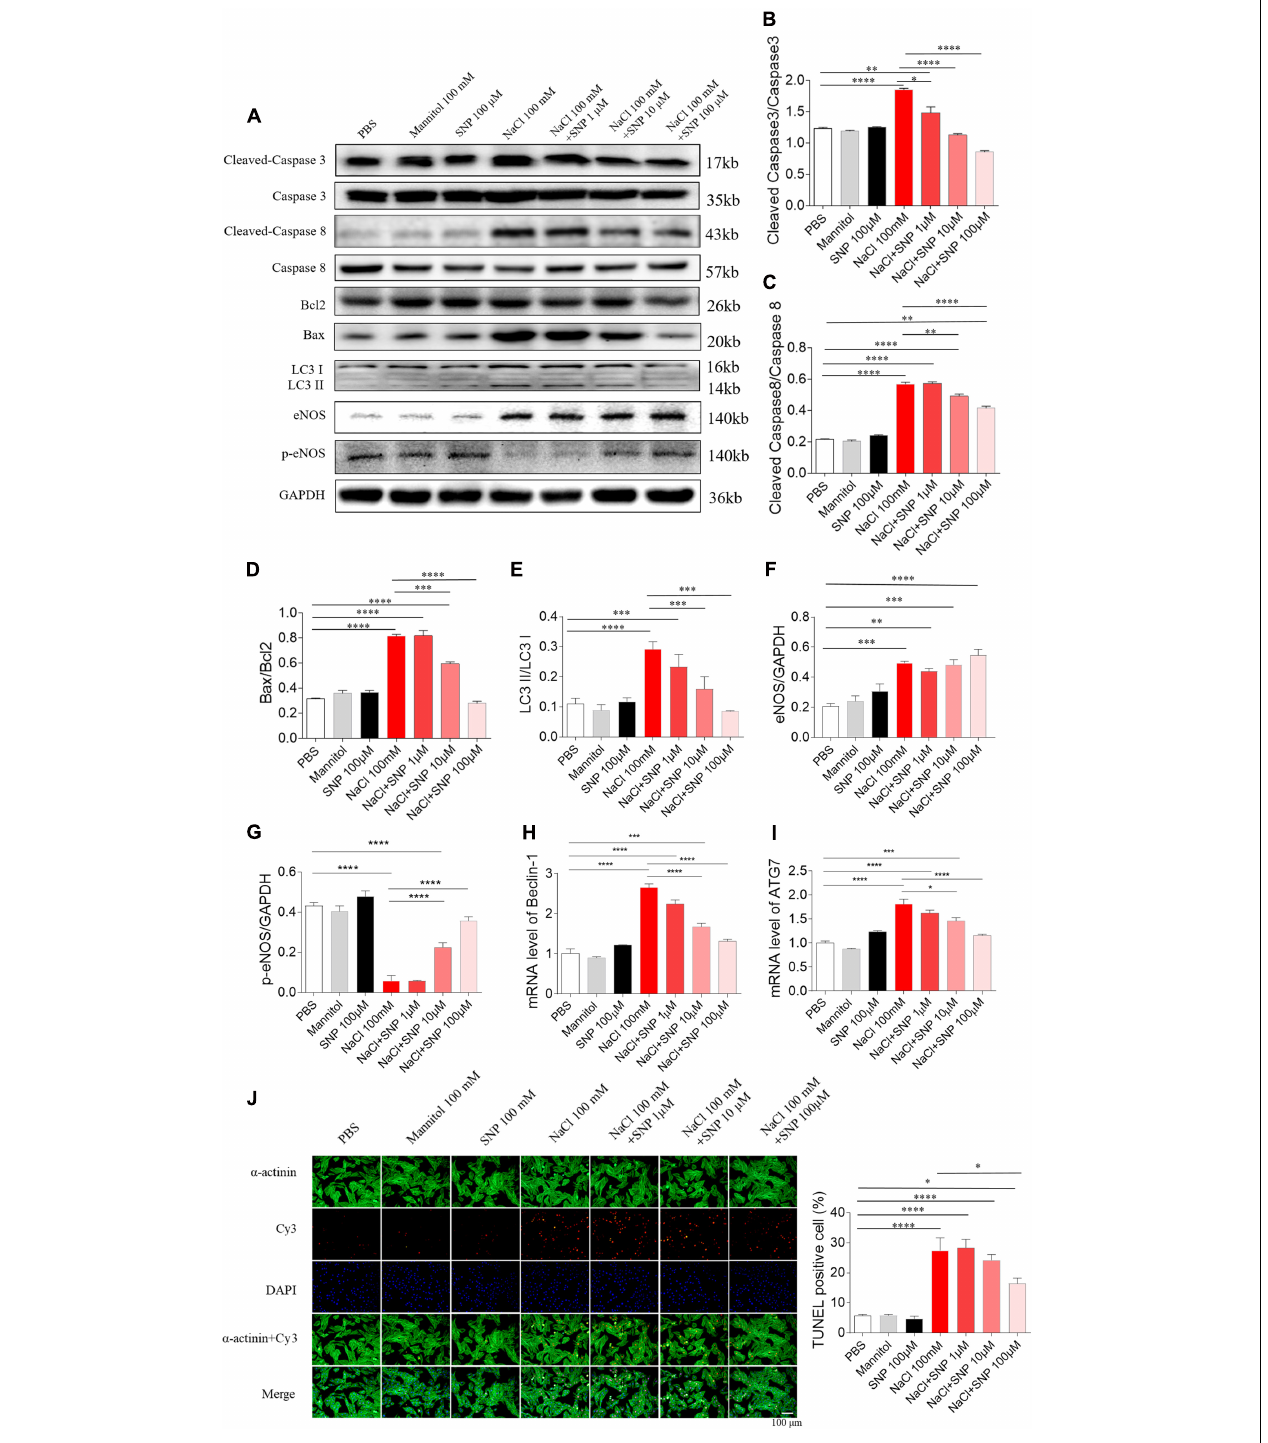
FIGURE 5 | Effects of different doses of nitric oxide donor sodium nitroprusside (SNP) on NaCl-induced apoptosis and autophagy in H9C2 cells. (A–I) , SNP attenuated the increases in the levels of cleaved-caspase 3/caspase 3, cleaved-caspase 8/caspase 8, Bax/Bcl2, LC3 II/LC3 I, Beclin-1, and autophagy related 7 (ATG7), and enhanced the decrease of p-endothelial nitric oxide synthase (eNOS) induced by NaCl (100 mM) in H9C2 cells. (J) The increase of TUNEL-positive cell number was inhibited by high dose of SNP (100 µ M), but not middle (10 µ M) or low dose (1 µ M) of SNP. The results are expressed as mean ± SEM. * p < 0.05, ** p < 0.01, *** p < 0.001, and **** p < 0.0001.